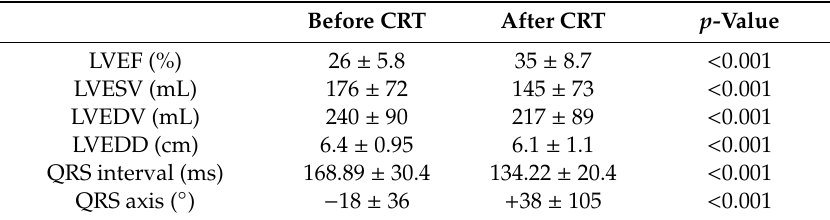
Table 3. Echocardiographic and electrical parameters before and after cardiac resynchronization therapy